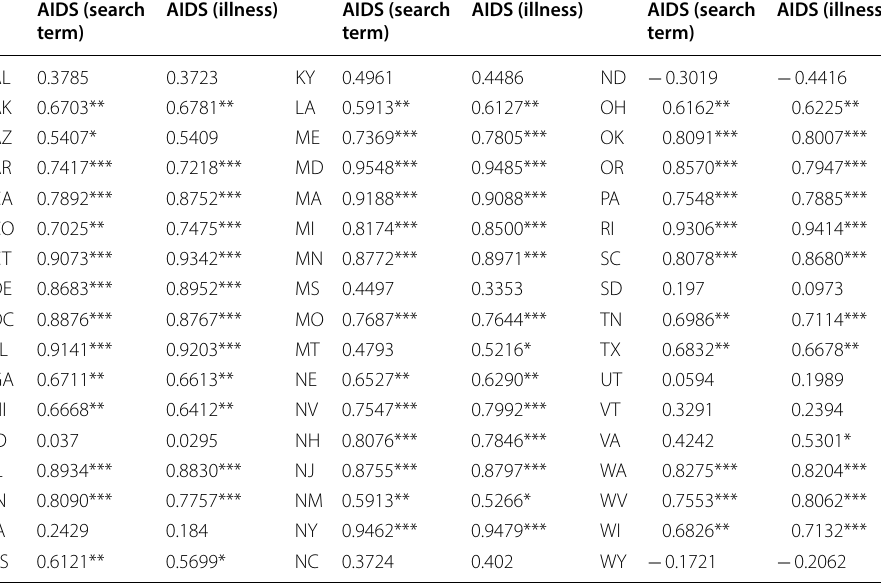
Table 2 Pearson correlation coefficients between ‘AIDS Diagnoses’ and (a) AIDS (Search Term)’ and (b) ‘AIDS (Illness)’ from January 2004 to December